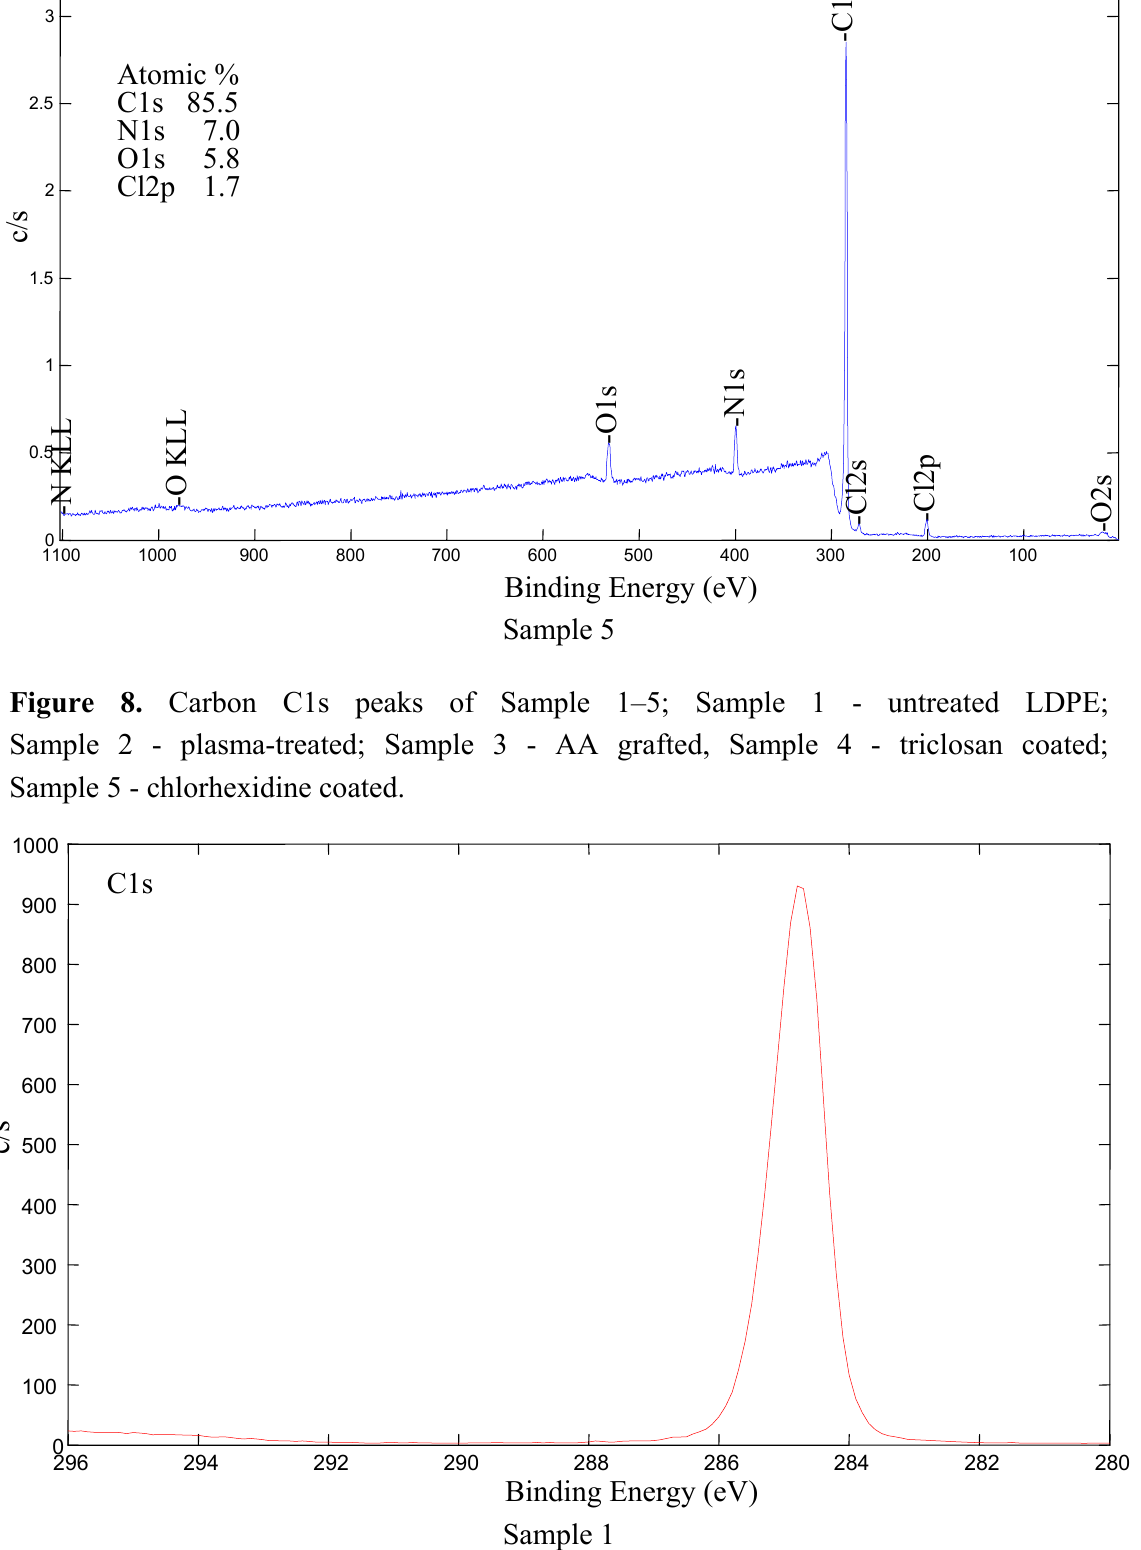
Binding Energy Sample 1